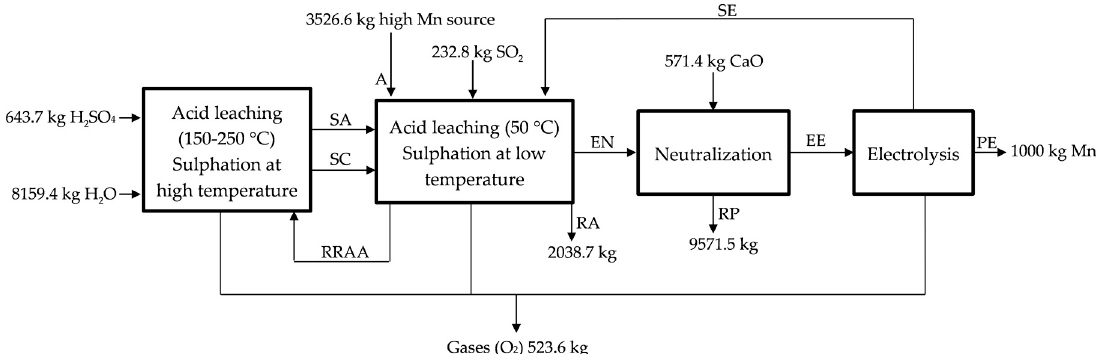
Figure 1. Process used for treating anodic lodes and scrapings from the zinc electrolysis process. SA, exit of acid leaching at high temperature; SC, hot sulfated; RRAA, recycled residue of acid leaching; A, high MnO 2 source; SE, exit of electrolysis; EN, entrance to neutralization; RA, residue low MnO 2